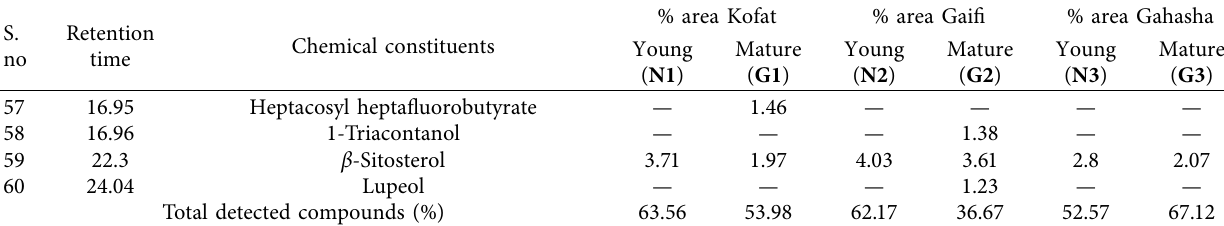
Table 2: Cytotoxic activity of the six extracts against three cell lines and one normal fibroblast (MTT 72h IC Ethanolic extract of